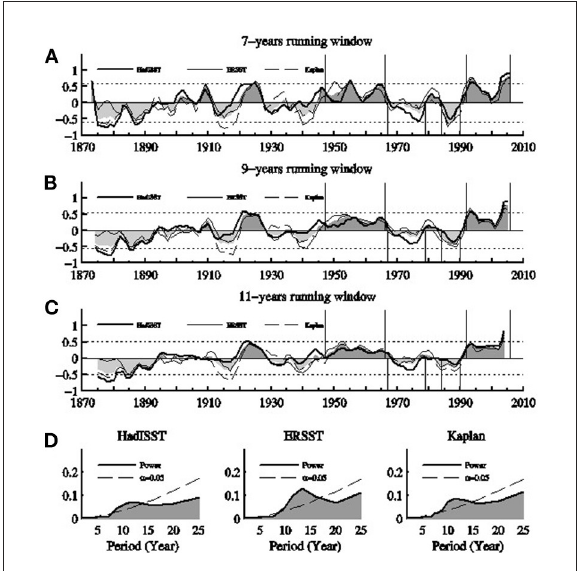
FIGURE1 Decadal variability of the IOD-ENSO correlation at the one-year time lag in HadISST, ERSST, and Kaplan SST data. The lag correlations between the SSTA in STIO in fall and the Niño3.4 SSTA in the following fall are calculated in 7-year (A) , 9-year (B) , and 11-year (C) sliding windows, with the vertical axis showing window central year. Horizontal dashed lines indicate 95% confidence level. The bottom panel (D) shows the power spectra of the lag correlations in the 7-year sliding window with statistics calculated from 1945 to 2009. Dash curves indicate 95% confidence level based on the Student’s- t test. Vertical lines mark the positive and negative phase periods.